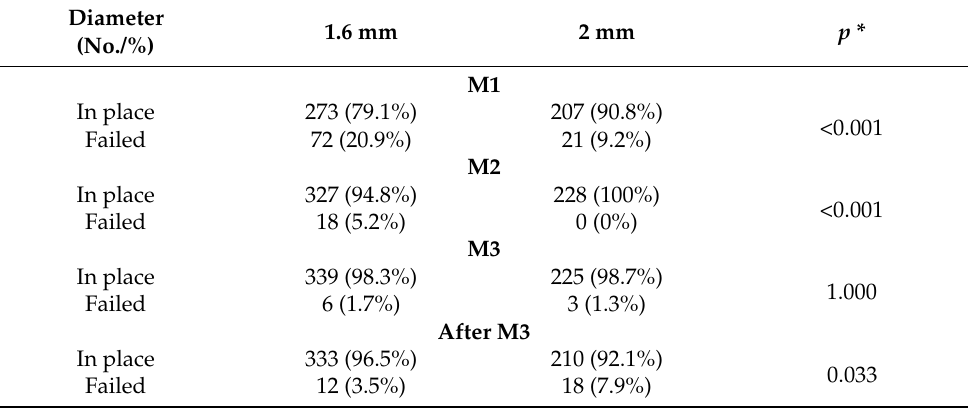
Table 6. Distribution of the mini-implants according to implant diameter and the rejection rate in M1, M2, M3 and after